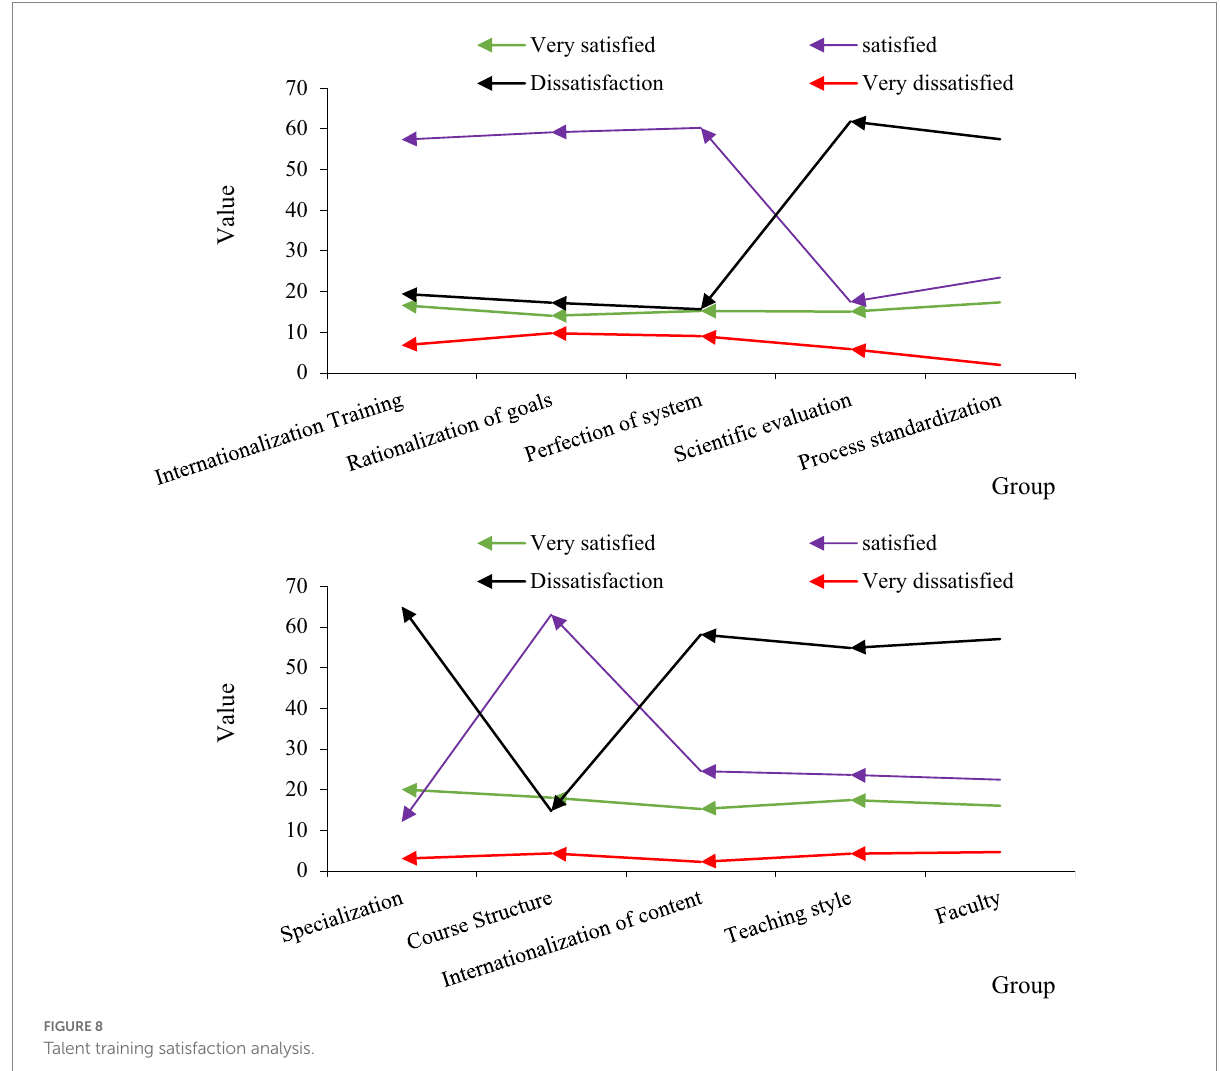
FIGURE 8 Talent training satisfaction